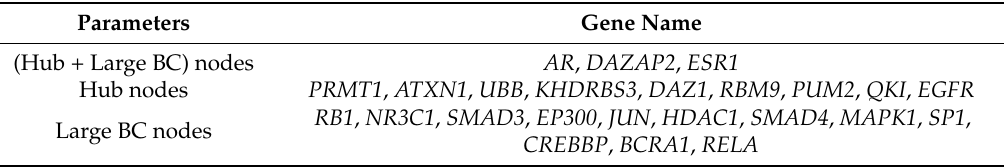
Figure 1. ( A ) Histogram showing distribution of the shortest path. Two randomly selected nodes were connected via 2.85 links; ( B ) The small (simplified) network of the Protein-Protein Interactions (PPIs) of azoospermia. The identified important nodes and their interconnected nodes were extracted to construct a new small PPI network. This new network consists of 46 nodes and 157 links. The key nodes are highlighted in yellow. Table 1. Hub nodes and large BC nodes.